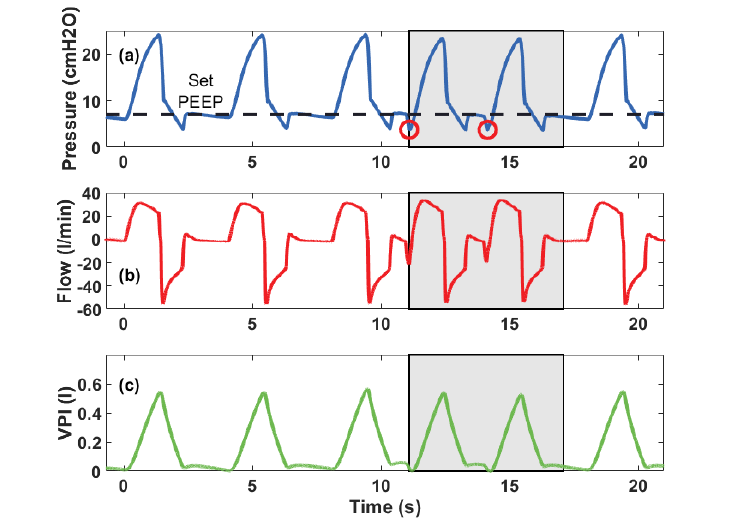
Figure 5. Measurements performed in order to demonstrate the additional features that can be implemented relatively easily with a digital control and a pressure sensor. Respiration rate was set to 15 BPM with inspiration to expiration ratio set to 1:2. The system was also set to trigger a breathing cycle in case of a potential inspiration (marked in gray) and to maintain positive end-expiratory pressure (PEEP), which was done with an additional mechanical PEEP valve and pressure dependent motor control. ( a ) Pressure obtained along several respiratory cycles. An inspiration was triggered when the pressure dropped by 2 cm H 2 O (red circles) with respect to PEEP. This pressure drop is the signal that corresponds to a patient attempting to breath in. PEEP was set to 7 cm H 2 O (dashed line). ( b ) Flow as a function of time. ( c ) Volume pumped as a function of